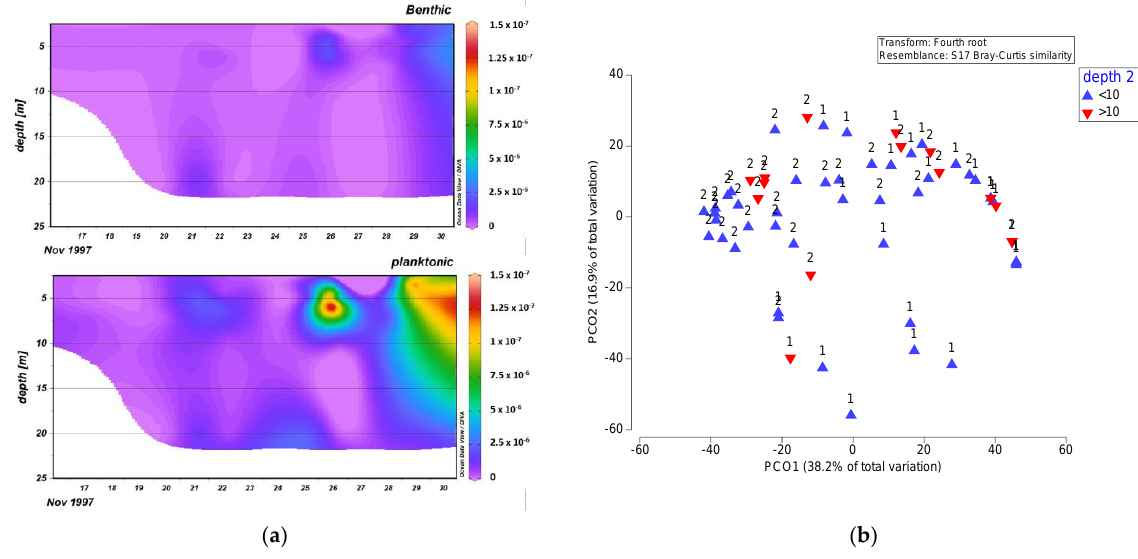
Figure 6. Phytoplankton community, PIPEX Station. ( a ) Benthic and pelagic diatom abundance in cell l −1 , daily average. ( b ) Principal coordinate analysis based on counts, labelled as depth < 10 m and > 10 m and dates as phase “1” (up to 22 Nov) and phase “2” (from 25 November).